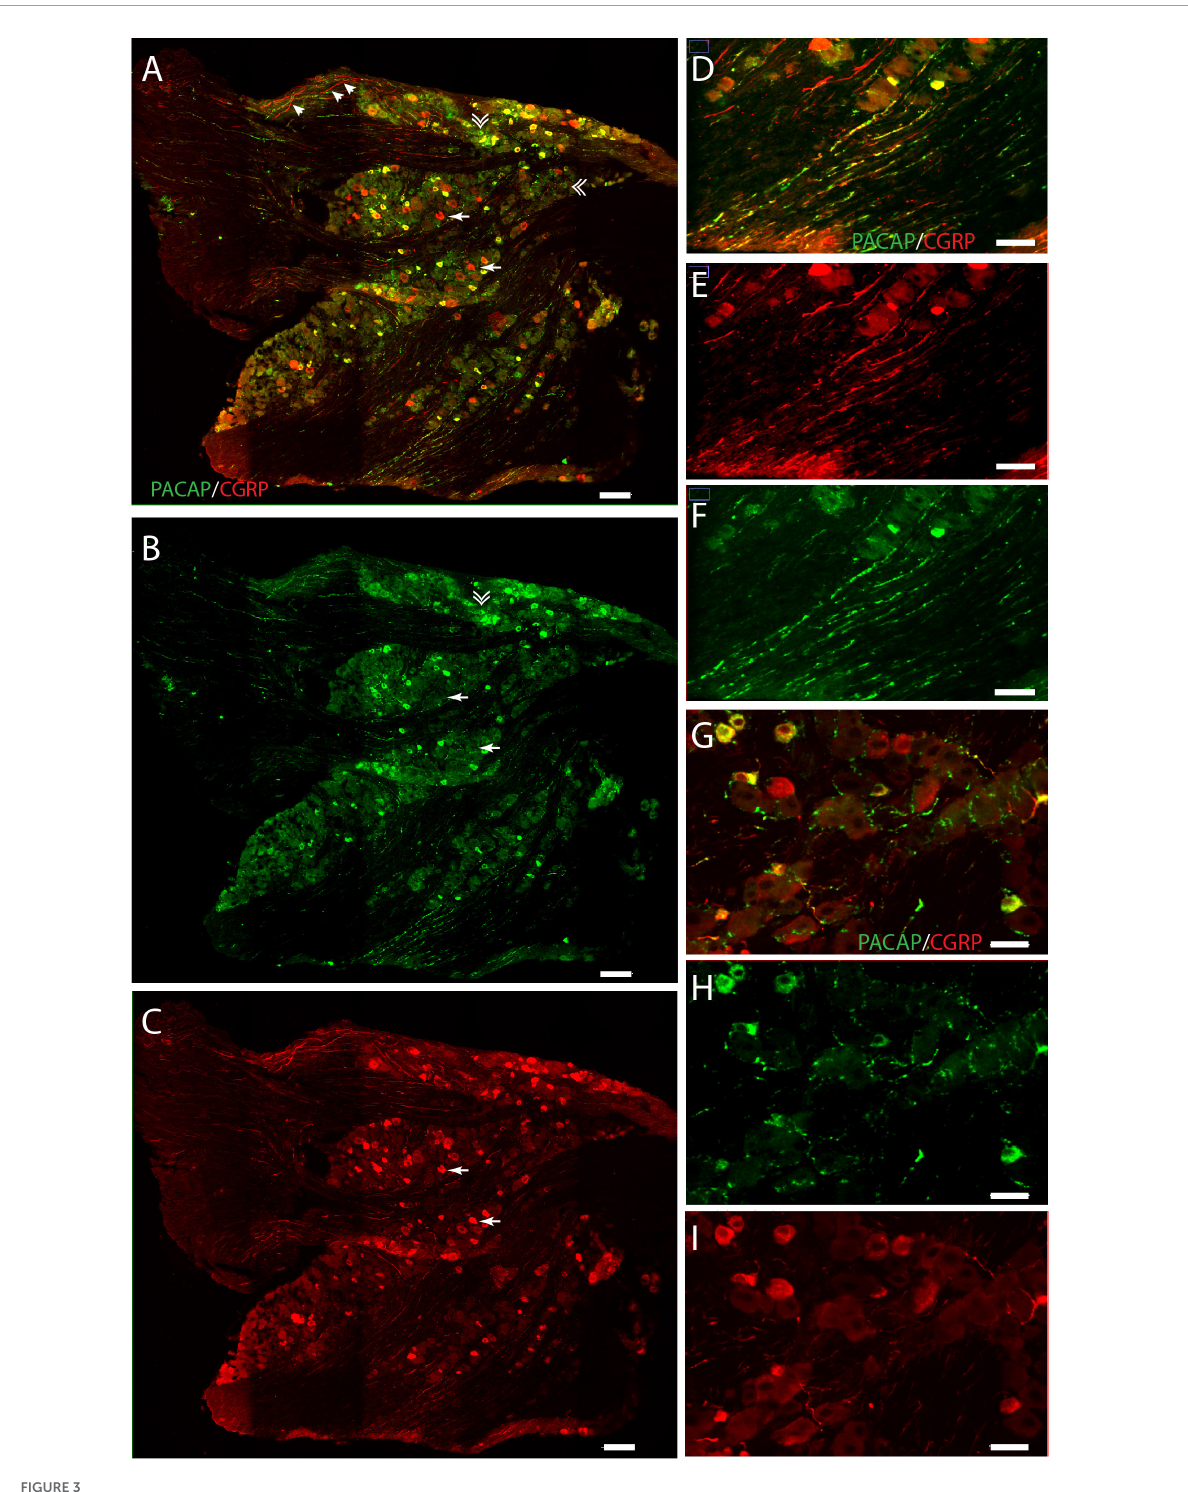
FIGURE3 Distribution of PACAP (green) and CGRP (red) immunoreactivity in the trigeminal ganglion. Panels (A–C) provide an overview with double immunostaining (A) , PACAP (B) , and CGRP (C) . Arrows in panel (A) indicate cells expressing solely CGRP, double arrows indicate cells expressing only PACAP, and arrow tips show immunoreactive nerve fibers. Higher magnification in panel (D–F) visualizes nerve fibers with double immunostaining (D) , CGRP (E) , and PACAP (F) . PACAP-positive delicate nerve fibers between neurons in close apposition, suggesting innervation (G–I) . Scale bars (A–C) = 100 µ m, (D–F) = 50 µ m, (G–I) = 30 µ